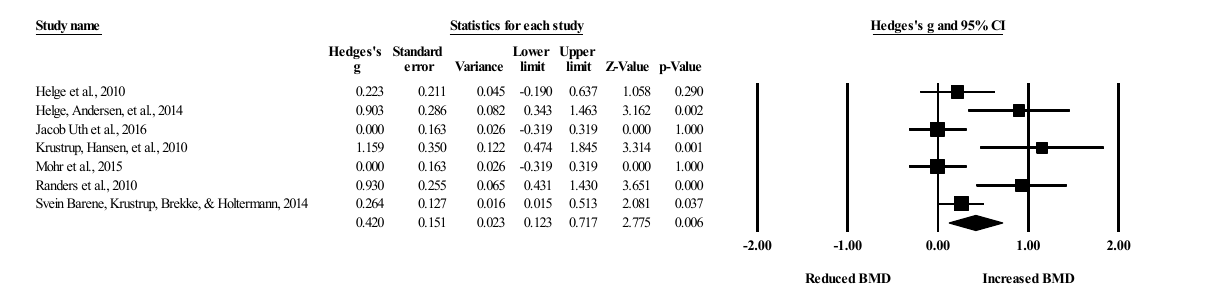
Figure 12. Forest plot of within-group changes in lower body bone mineral density (BMD) in untrained adults after a training program based on soccer small-sided games. Values shown are effect sizes (Hedges’s g) with 95% confidence intervals (CI). The size of the plotted squares reflects the statistical weight of each study. The black diamond reflects the overall result.